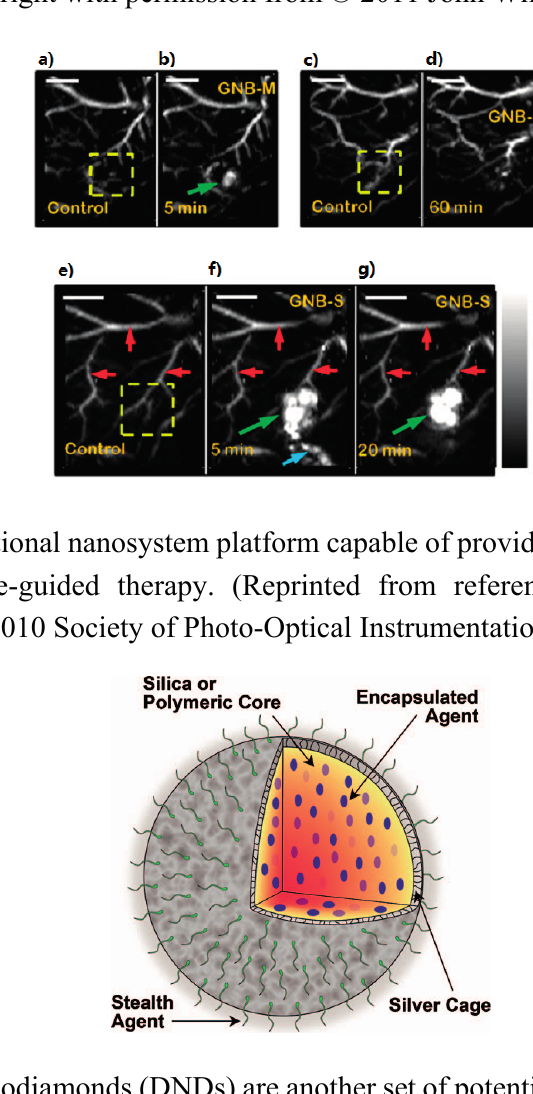
Figure 2. In vivo noninvasive photoacoustic imaging of sentinel lymph nodes in rat ( λ = 767 nm). ( a – g ) Scale bar is 5 mm. Aliquots of 150 mL of nanobeacons were injected intradermally in all cases. GNB-M: ( a ) control PA image; ( b ) 5 min post-injection image of GNB-M (5 mM); GNB-L: ( c ) control PA image; ( d ) lymph node is not visible in a 60 min post-injection image of GNB-L (680 nM); GNB-S: ( e ) sagittal maximum amplitude projection (MAP) pre-injection control image; bright parts represent optical absorption from blood vessels, marked with red arrows; ( f ) PA image (MAP) acquired 5 min after GNB-S injection (10 nM); SLNs are clearly visible, marked with green arrows; lymphatic vessel is also visible, marked with blue arrows; ( g ) 20 min post-injection PA image. (Reprinted from reference [37]. Copyright with permission from © 2011 John Wiley & Sons, Ltd.).